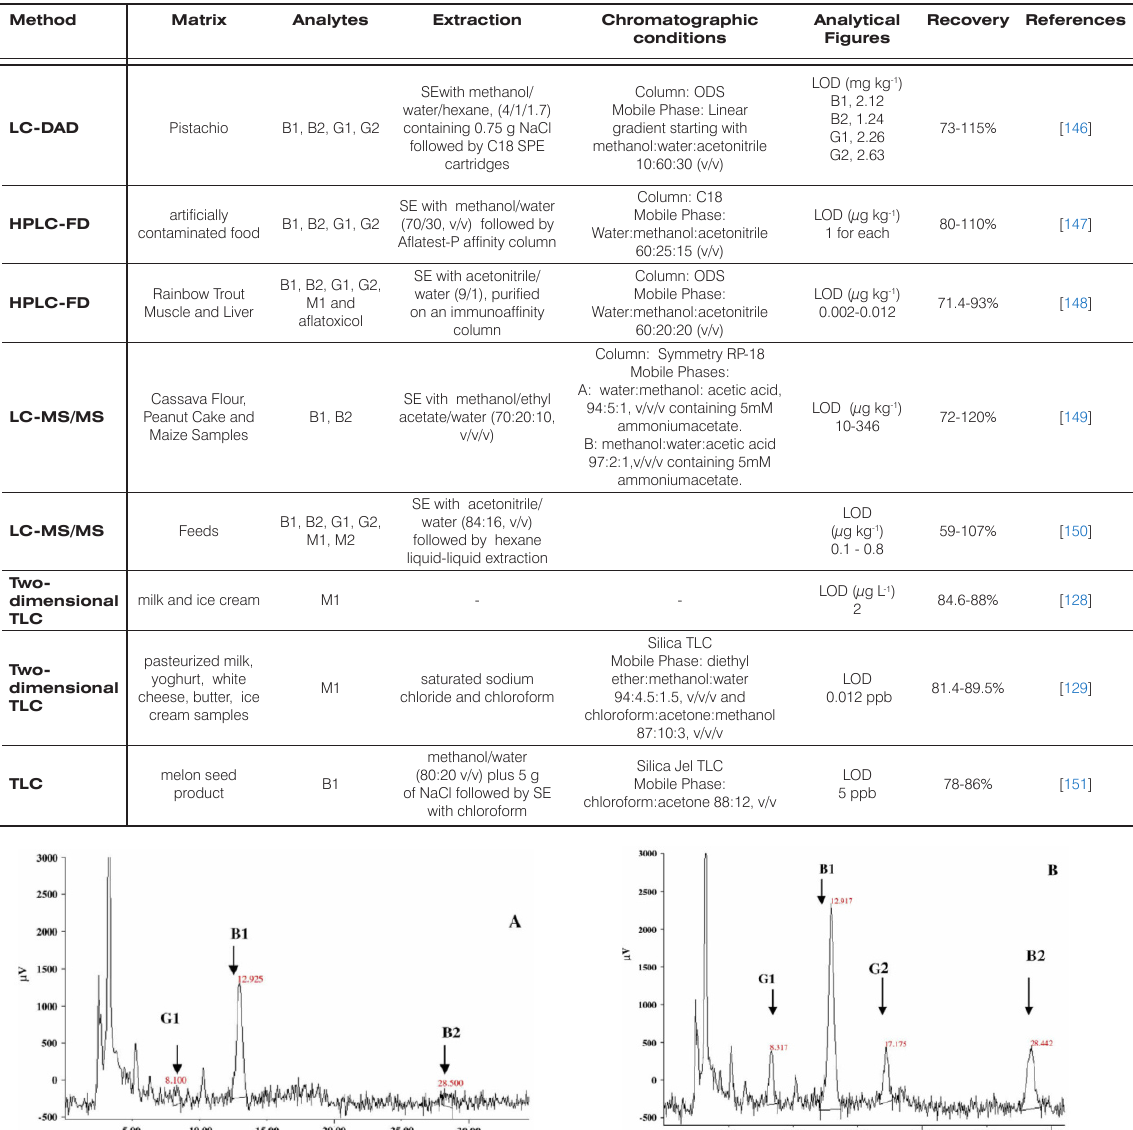
Table 4. Some examples for species determination of aflatoxins.